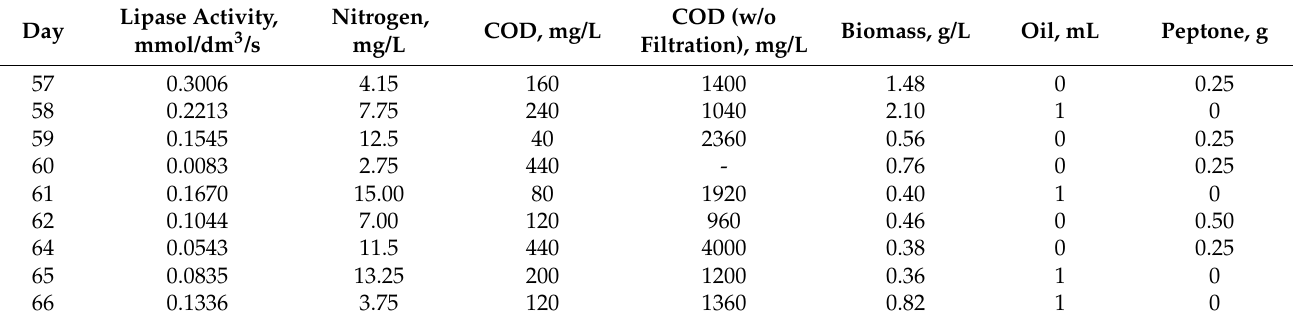
Table 1. Batch bioreactor measurements between 57th and 66th